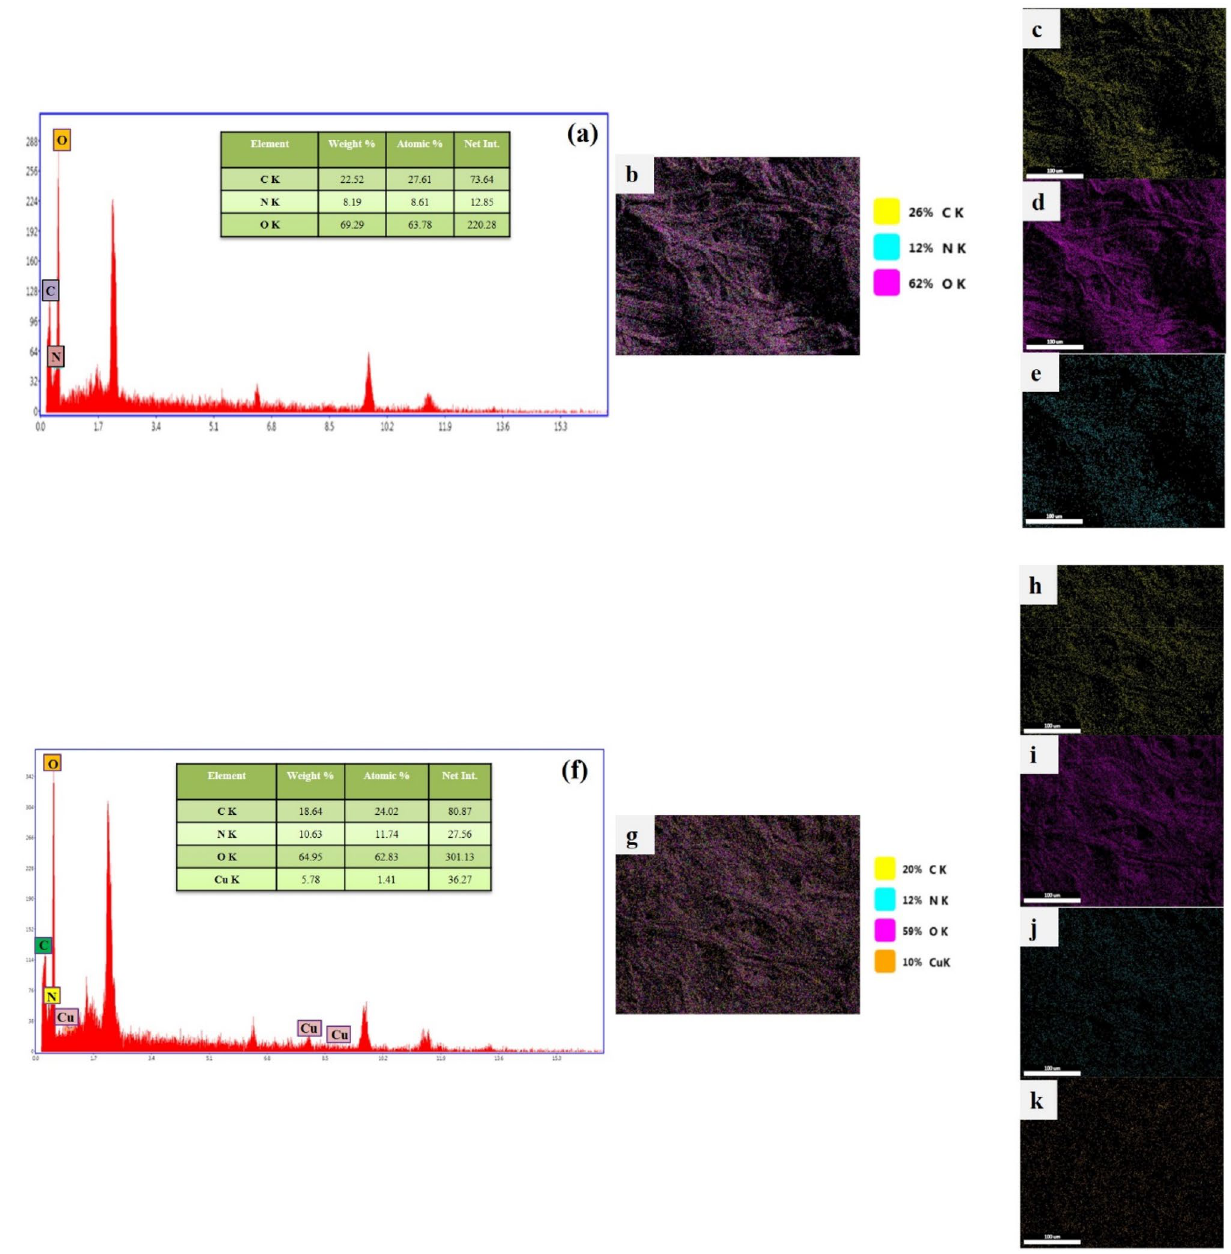
Figure 5. (a) The EDX spectrum of CS-FP; (b) overall mapping elements: corresponding to carbon (c) , oxygen (d) , and nitrogen (e) . (f) The EDX spectrum of Cu@CS-FP; (g) overall mapping elements: corresponding to carbon (h) , oxygen (i) , nitrogen (j) , and copper (k)